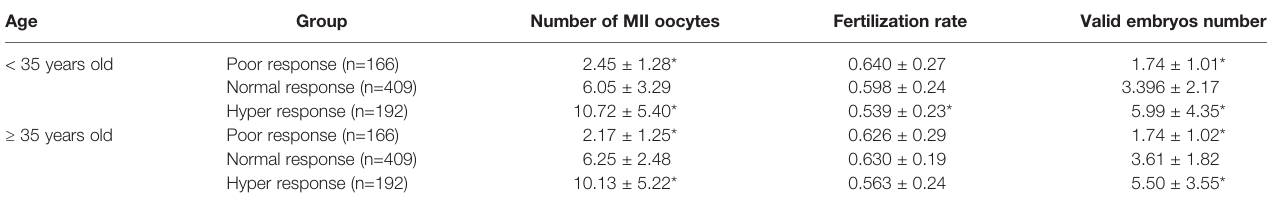
TABLE 2 | Laboratory results of different ovarian response